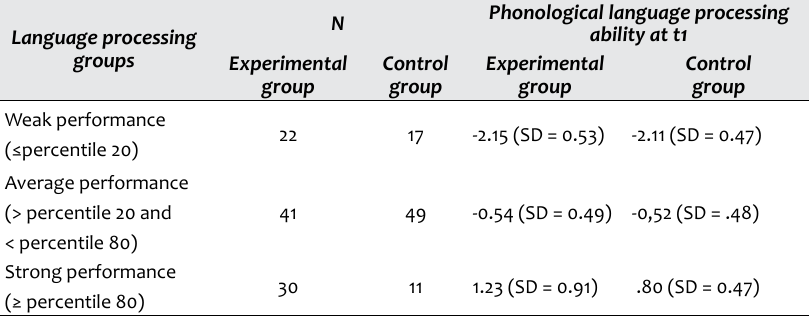
Table 2: phonological performance of the language processing groups at